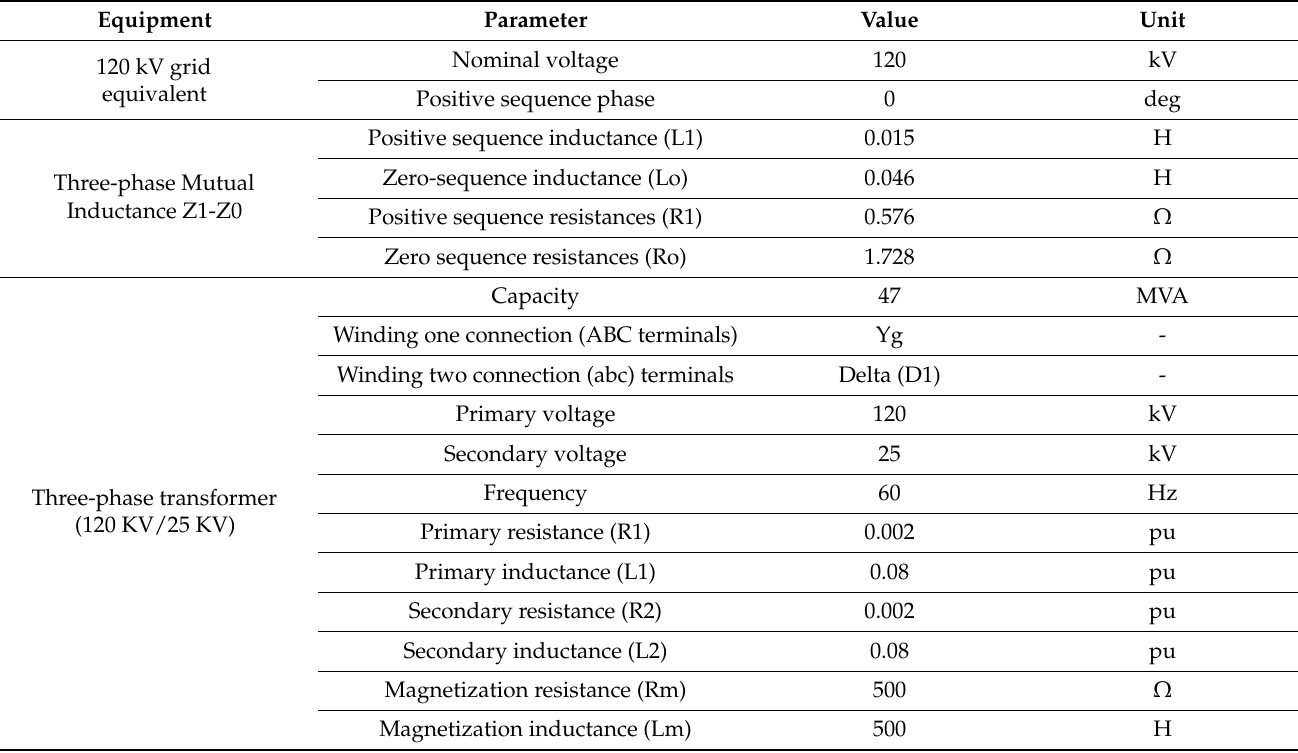
Figure 5 . Detail model for SCIG wind turbine and generator under the mask. Figure 5. Detail model for SCIG wind turbine and generator under the mask. Table 1. Network parameter values for simulated SCIG and Table 1 . Network parameter values for simulated SCIG and DFIG.